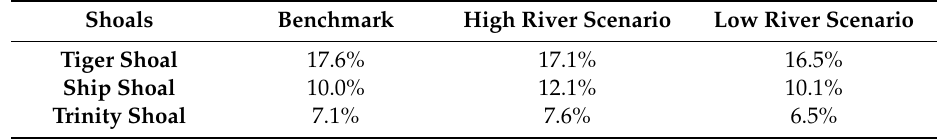
Table 2. Percentage of fluvial sediments over each